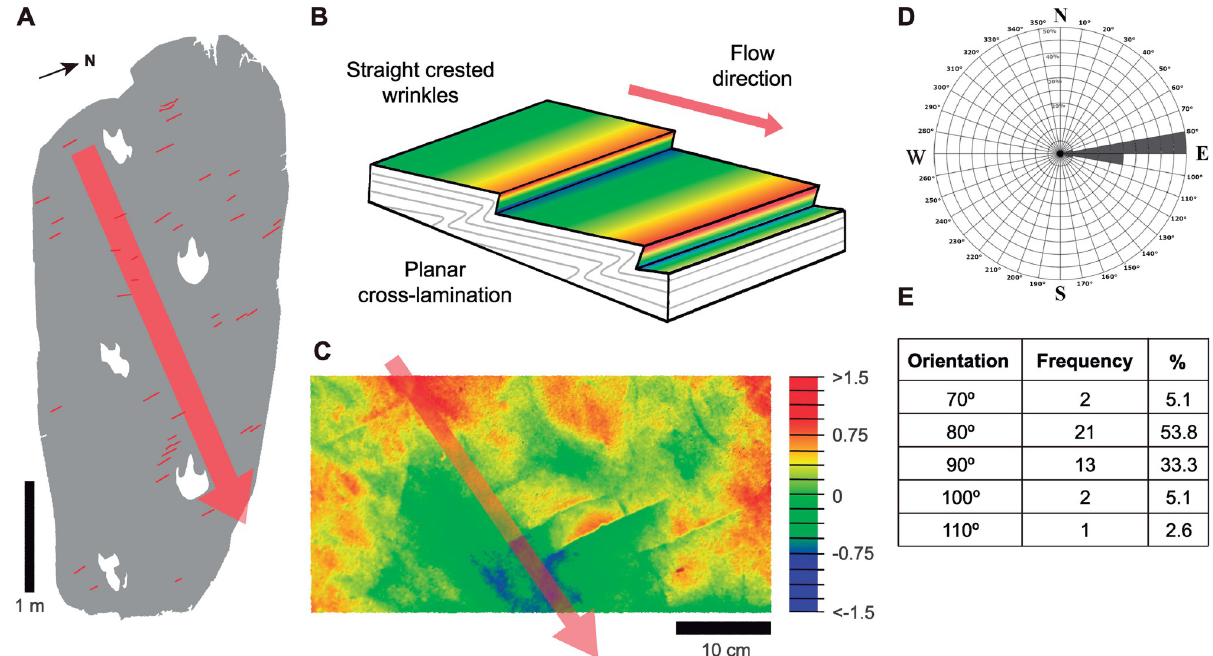
Fig 7. Magenta LH-Mg-10-16 surface structures. (A) Distribution of wrinkles (in red) on the layer. (B) Schematic view of the wrinkles following the analogy of ripple marks formation. (C) Wrinkles with color ramp and depth scales in cm. The red arrow indicates the direction of the flow. (D) Rose diagram showing the resultant current flow orthogonal to the fold orientations. (A) Layer #16 with the distribution of wrinkles in red. (B) Schematic view of the wrinkles following an analogy of ripple marks formation. (C) Wrinkles with color ramp and depths (scale in cm). (D) Rose diagram showing the resultant current flow, orthogonal to the wrinkle orientations. The red arrow indicates the direction of the flow.